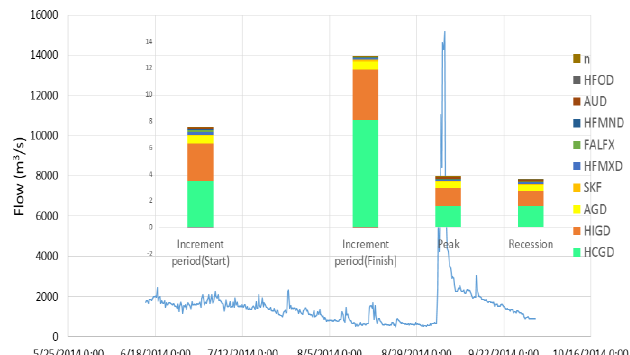
Fig. 8. Sensitivity indices of parameters variation at different flow regimes. Deterministic index for Jhelum river basin